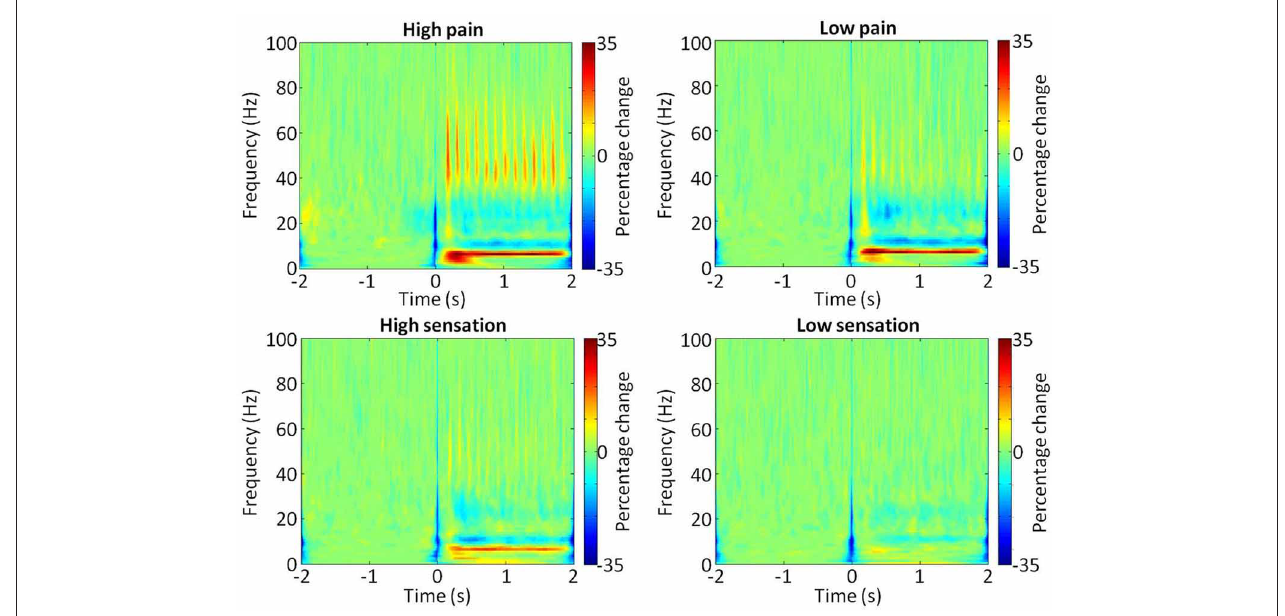
FIGURE 2 | Time-frequency representation of SI during stimulation. Normalized group average bootstrap spectrograms showing changes in power (%) at each frequency (0–100Hz) during the stimulation train (0–2s).